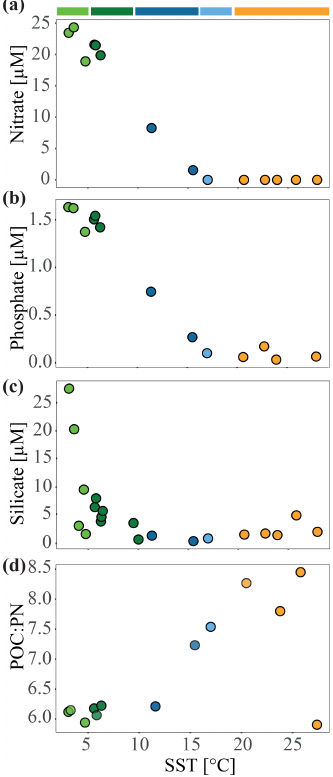
Figure 2. Nutrient concentrations (µmolL − 1 ) and molar ratios of particulate organic carbon (POC) to particulate nitrogen (PN) dur- ing the MD206 expedition against sea surface temperature ( ◦ C): (a) nitrate, (b) phosphate, (c) silicate, and (d) POC:PN ratio. Col- ored bars indicate water masses according to their sea surface tem- perature: yellow bar highlights the Indian South Subtropical Gyre (ISSG), light blue bar highlights the Subtropical Front (STF), blue bar highlights the Subantarctic Front (SAF), dark green bar high- lights the Polar Front Zone (PFZ), and light green bar highlights the Antarctic Zone